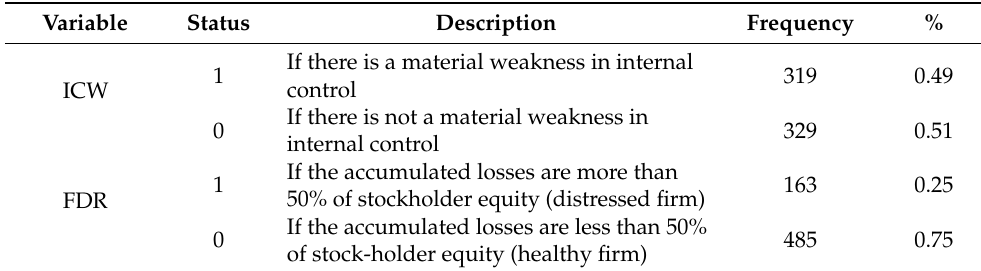
Table 4. Descriptive statistics of qualitative